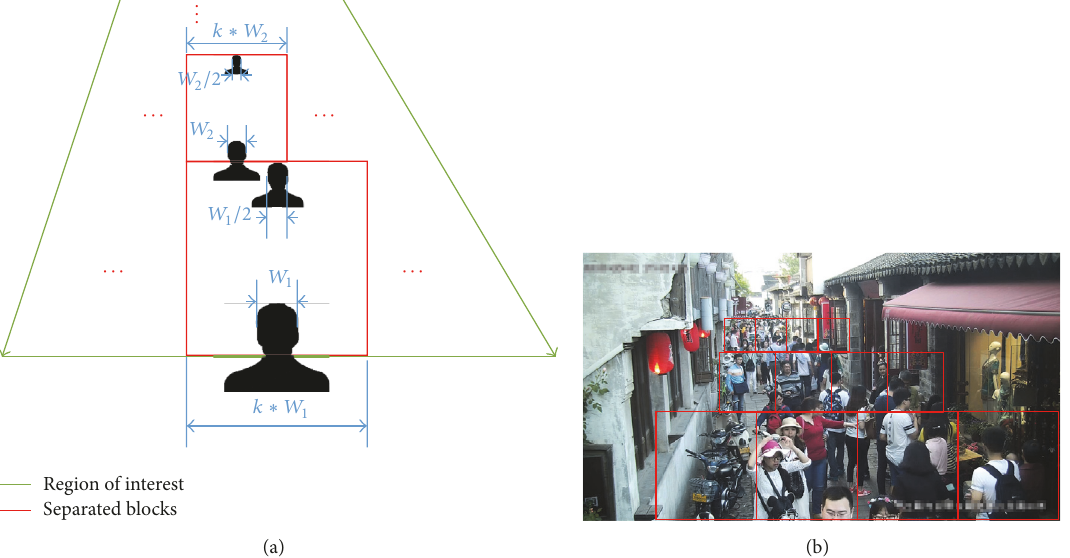
Figure 3: (a) Blocking method diagram and (b) blocking of a scenic spot